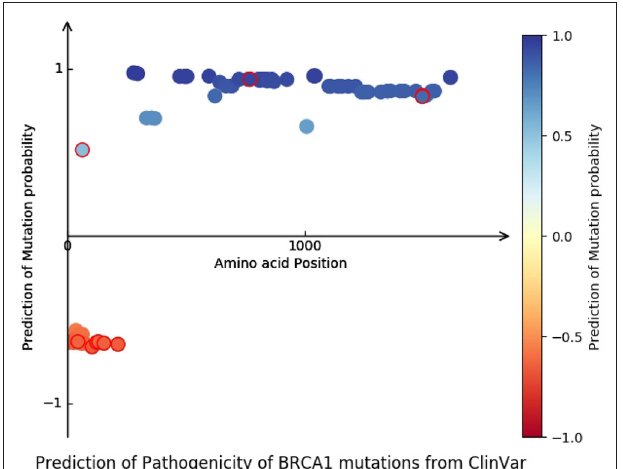
FIGURE 6 | Predictive performance of BertVS on the PTEN dataset from ClinVar. Receiver operating characteristic (ROC) curves of prediction results obtained by applying